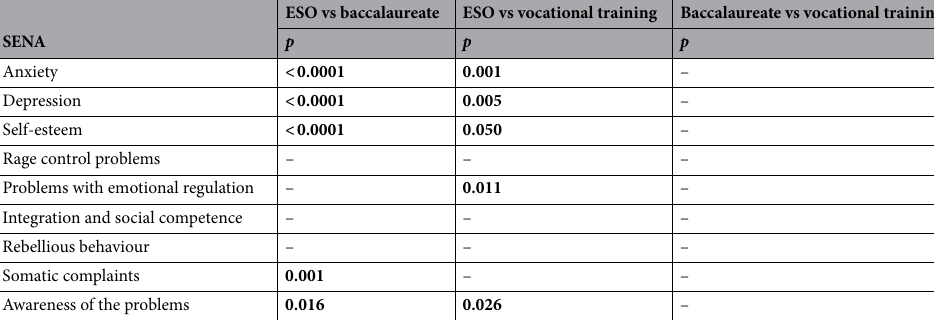
Table 6. Significance of the post-hoc differences (DMS test) between pair averages depending on the teenagers’ academic course during confinement. Only statistically significant differences are reported. ESO Secondary, Middle